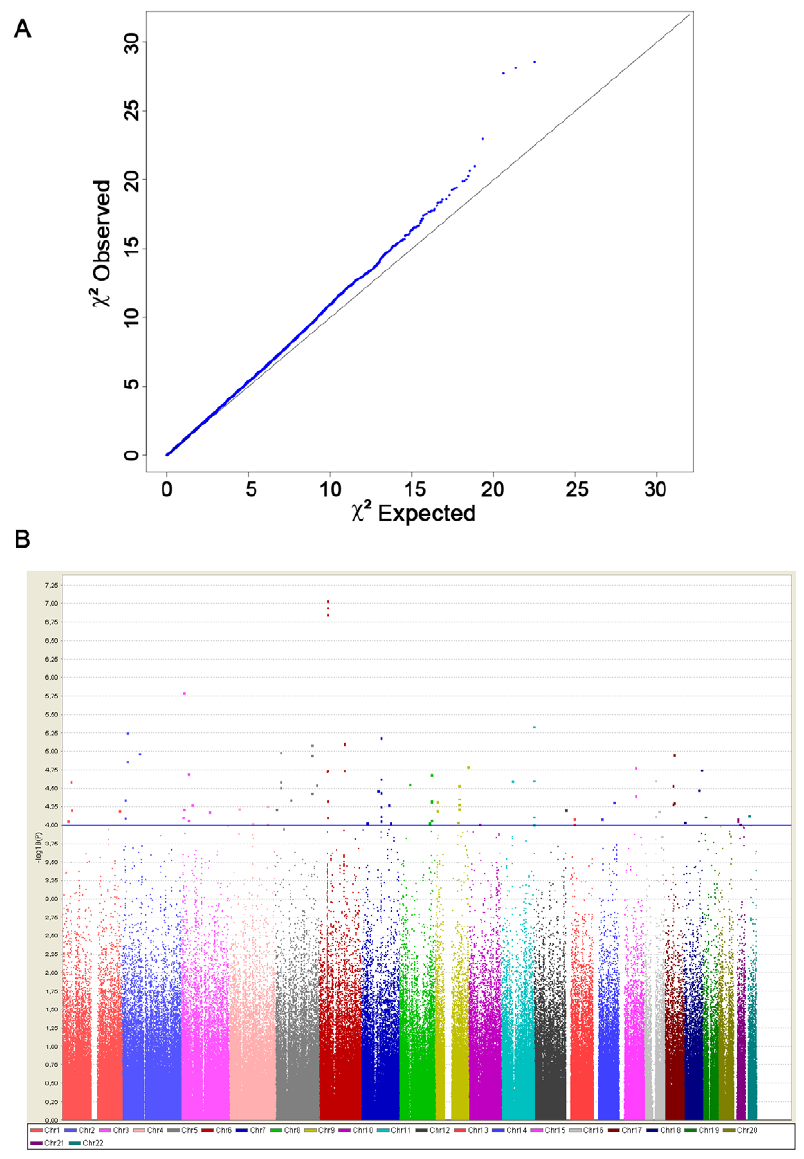
Figure 1. Genome-wide association results from the discovery phase. (A) Quantile-quantile plot for test statistics (logistic regression test) for 489,814 SNPs passing quality control. The plot shows a close match to the test statistics expected under the null distribution ( l =1.03). (B) Manhattan plot representing the P values across the genome. The 2 log10 P of the logistic regression test (y axis) from 489,814 SNPs in 564 systemic sclerosis patients and 1,776 controls is plotted against its physical position (x-axis) on successive chromosomes. 90 SNPs with P , 10 2 4 lie above the blue horizontal line and are listed in Table S1. Highly significant association was observed with SNPs within the MHC locus, including 1 SNPs that reached the conservative threshold for genome-wide significance (P , 10 2 7